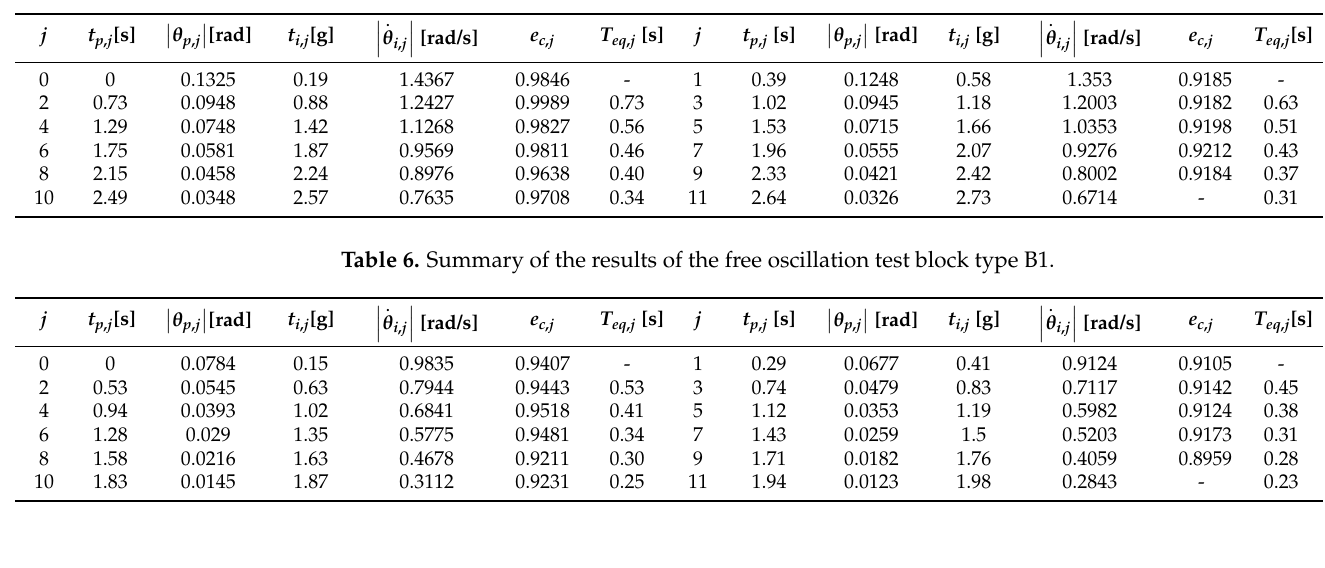
Table 5. Summary of the results of the free oscillation test block type A3.